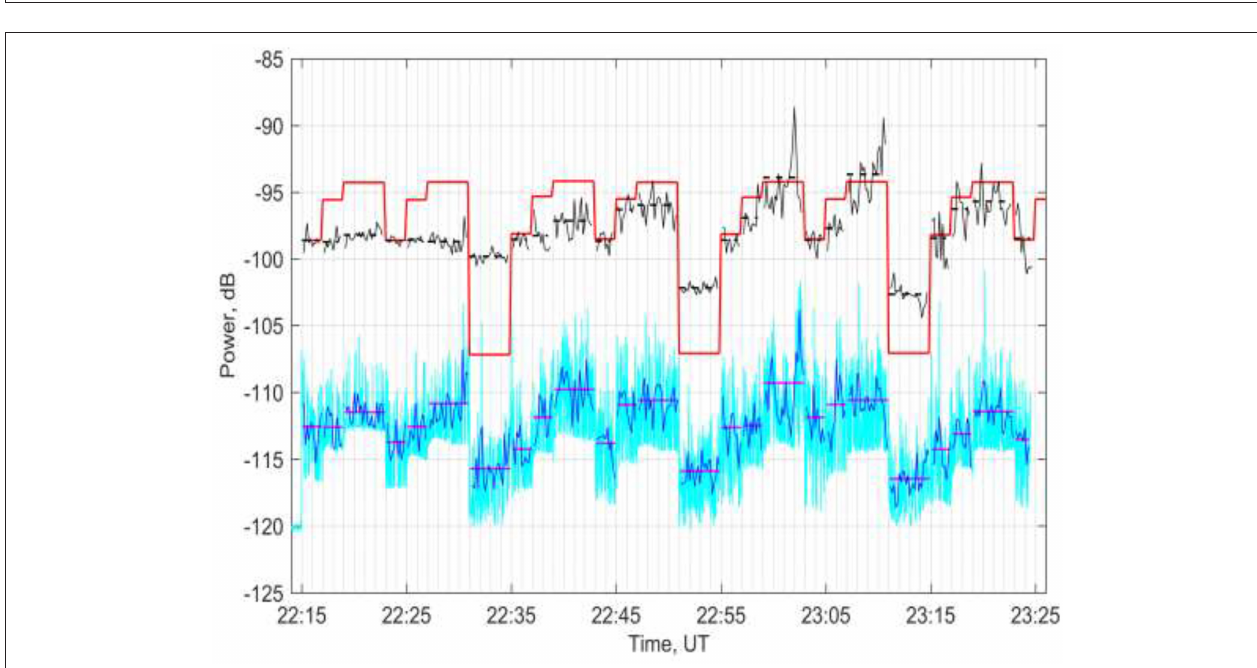
FIGURE 11 | Time series of the intensity of the broadband component of HF signal received at UAS (black curve), noise intensity (the blue curve), red histogram—log file of heater, and turquoise curves—intensity of DM SEE. March 17, 2018.